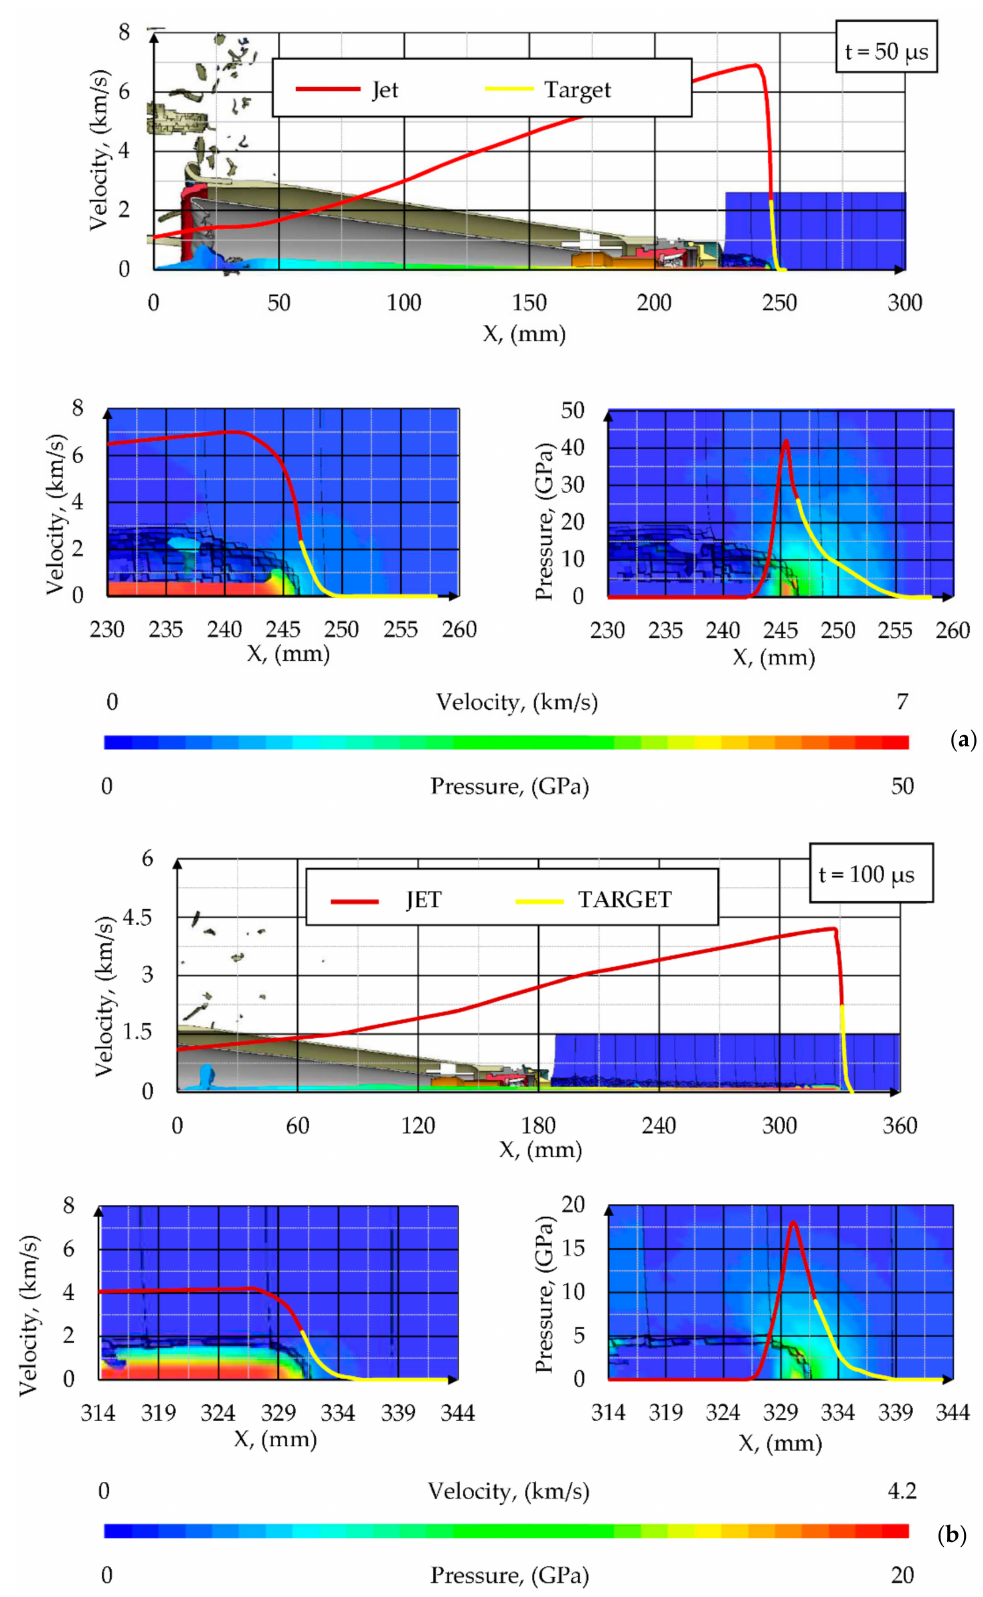
Figure 17. Distribution of jet velocity and pressure along the penetration axis at times ( a ) t = 50 µ s and ( b ) t = 100 µ s after detonation initiation of the PG-7VM